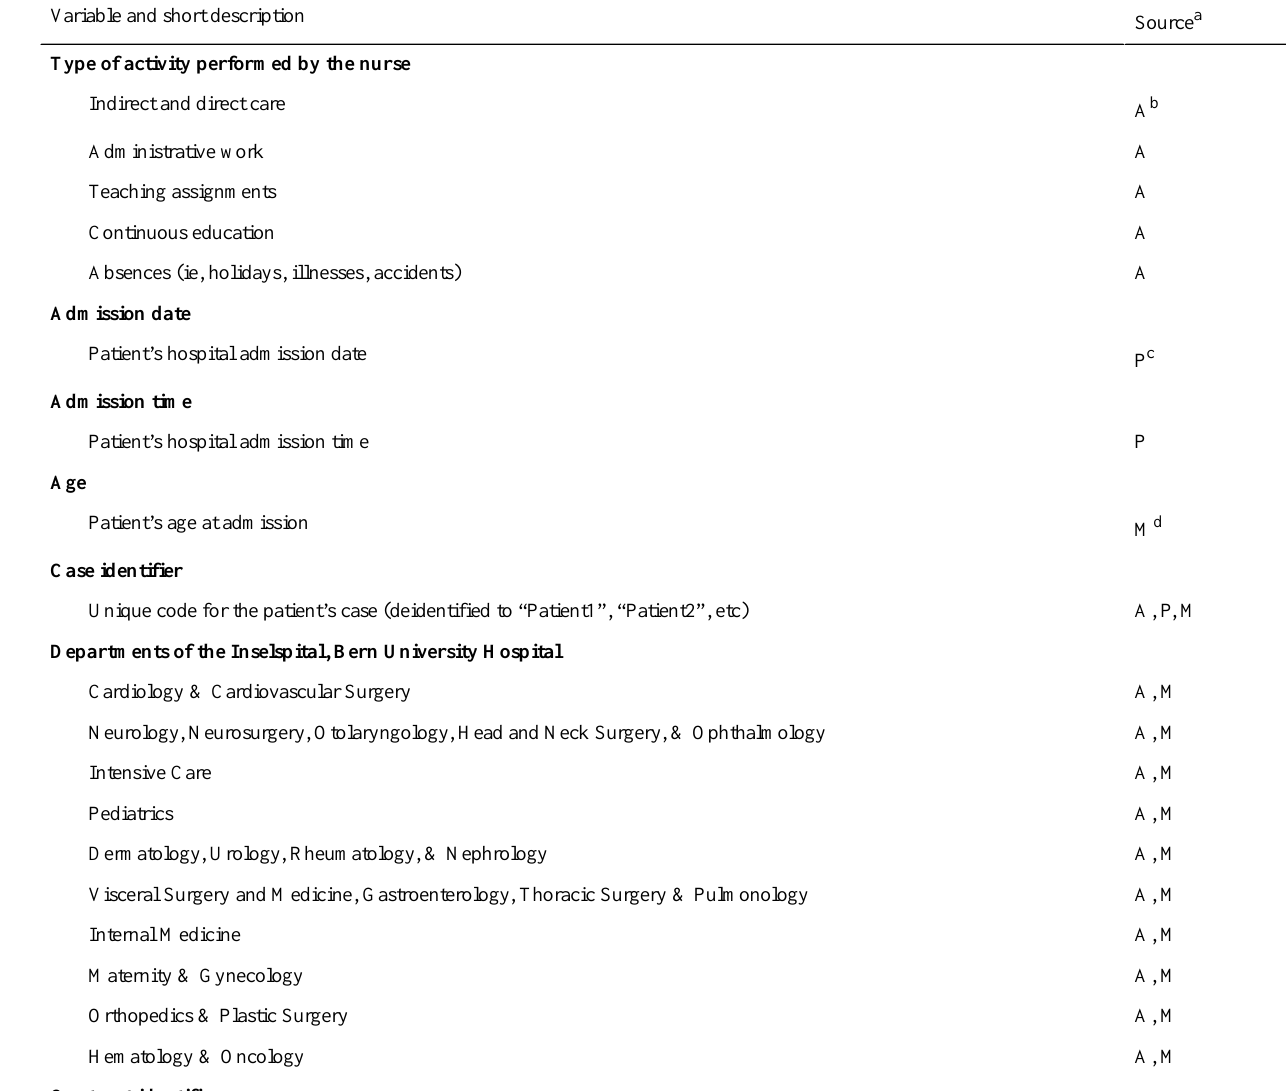
Table 1. Description of the 17 variables used for the current analysis, listed in alphabetical